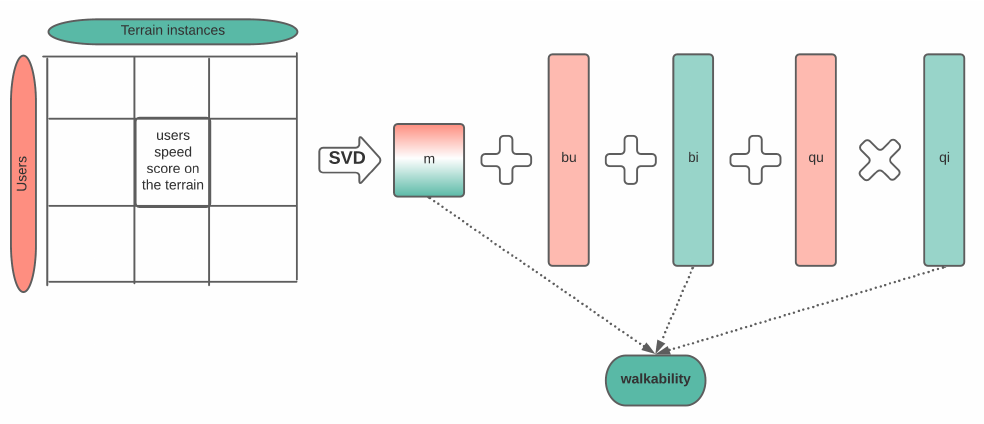
Figure 3: Extracting walkability values as latent values from the speed score matrix of users and terrain